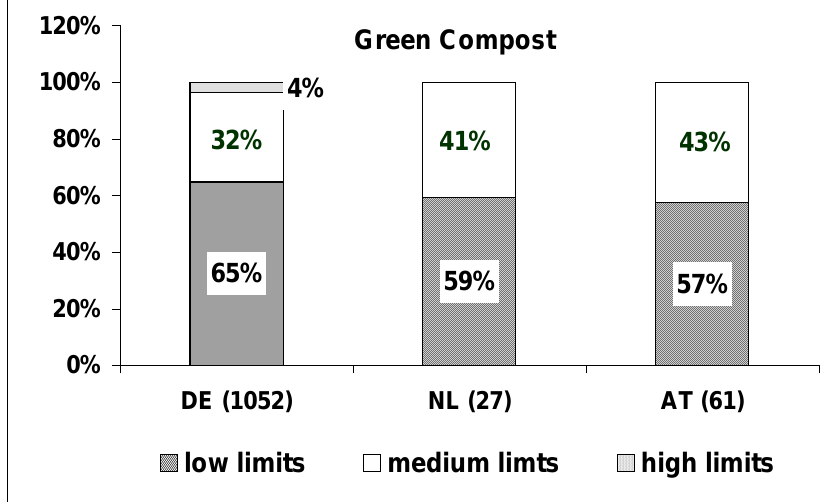
Figure 7: Percentage of GREEN WASTE compost samples from DE, NL and AT data sets within the three assumed limit concentration levels ( low, medium, high